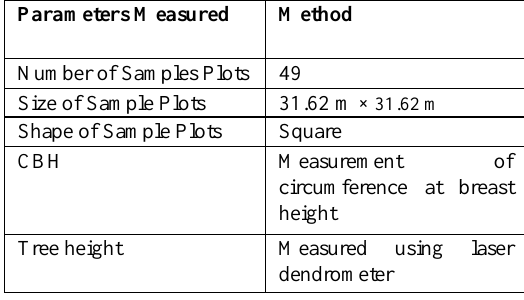
Table 3: Description of field data